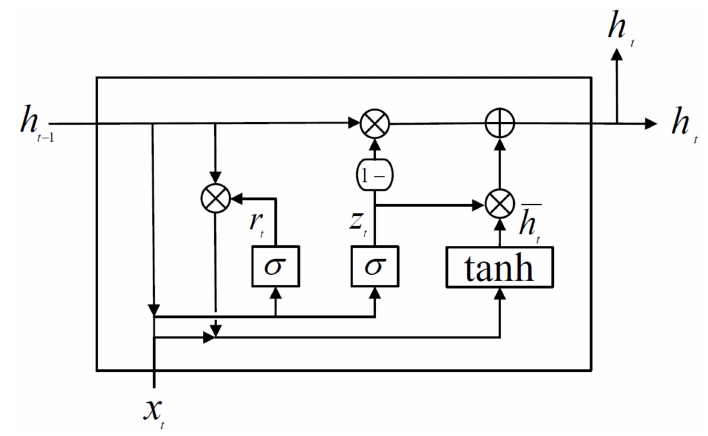
Figure 2. Gated Recurrent Unit